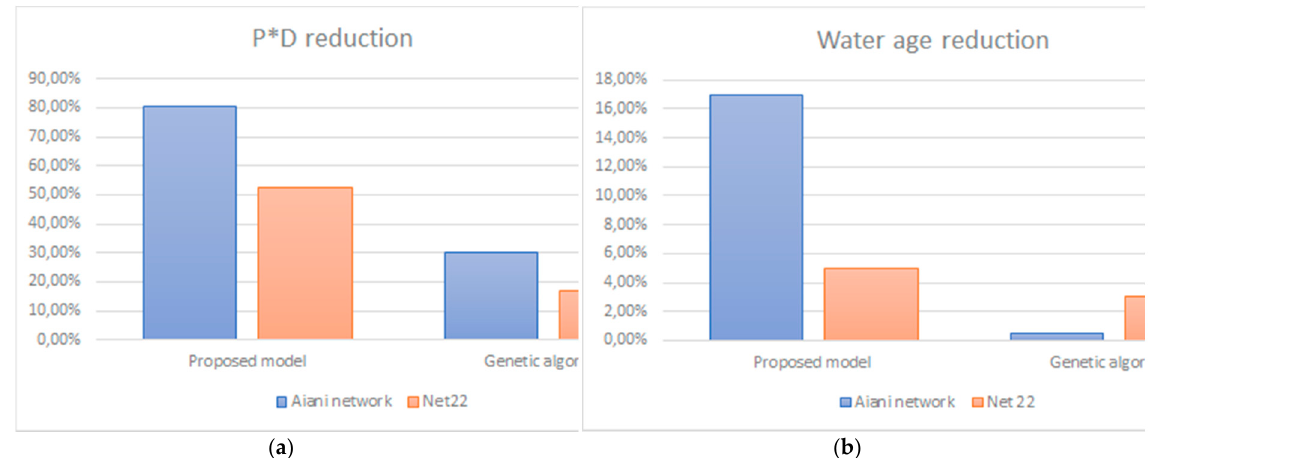
Figure 4. ( a ) Pressure*Demand product reduction; ( b ) water age reduction for both